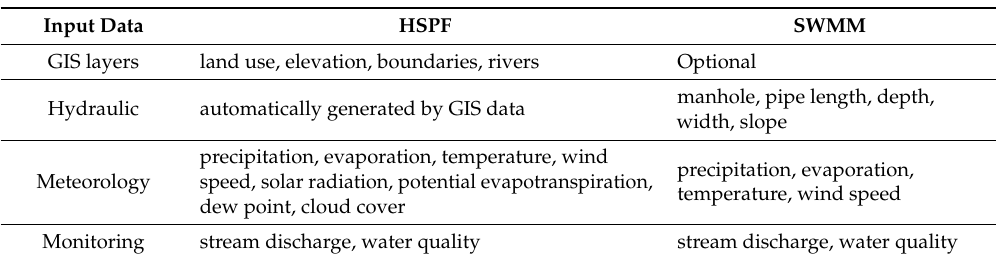
Table 1. Summary of the input data for the Hydrological Simulation Program-Fortran (HSPF) model and Storm Water Management Model